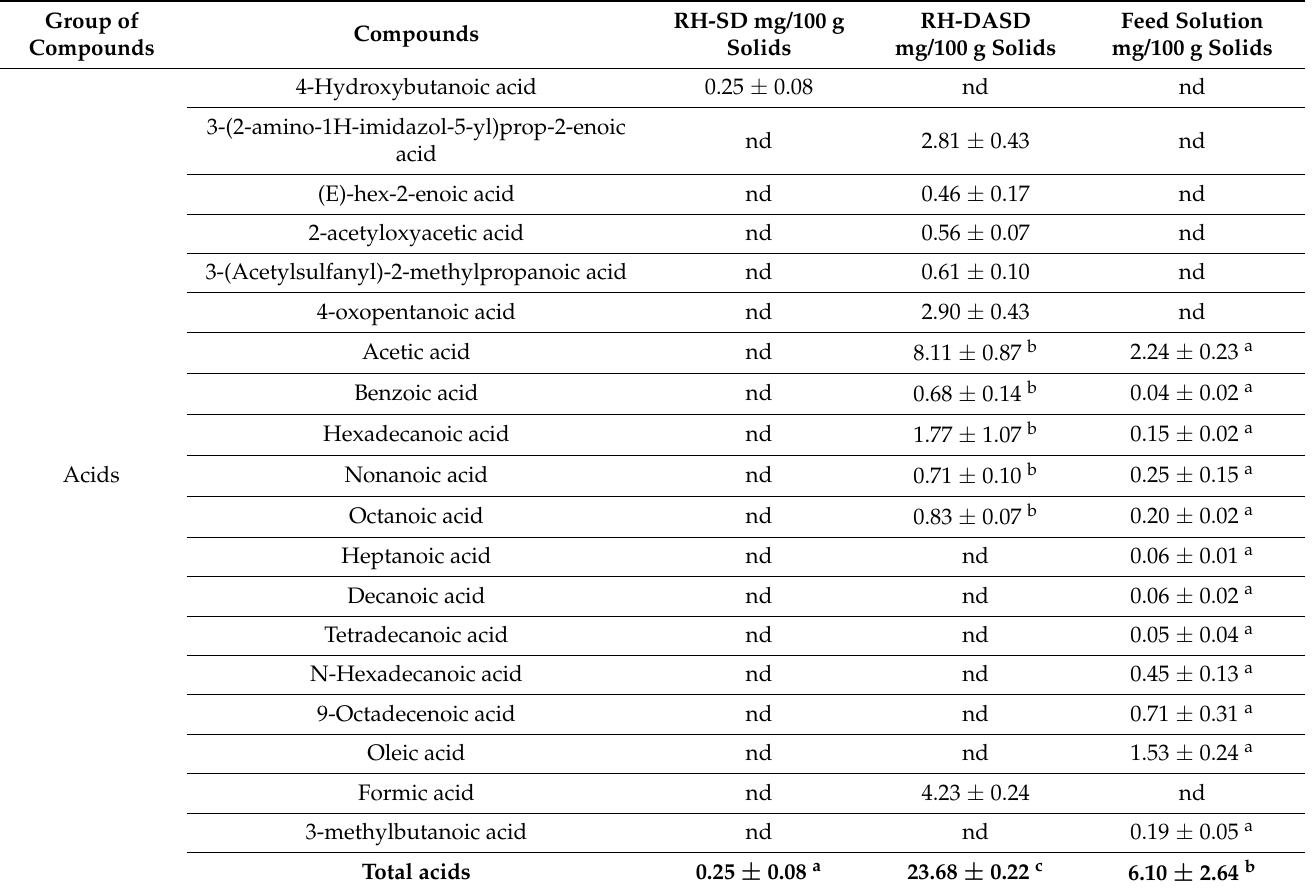
Table 3. Aroma compounds content in rapeseed and honeydew honey powders and solutions: SD—traditional spray drying, DASD—dehumidified air spray drying, RH—rapeseed honey, HH—honeydew honey. a–c: differences between mean values followed by different letters in rows were statistically significant ( p <